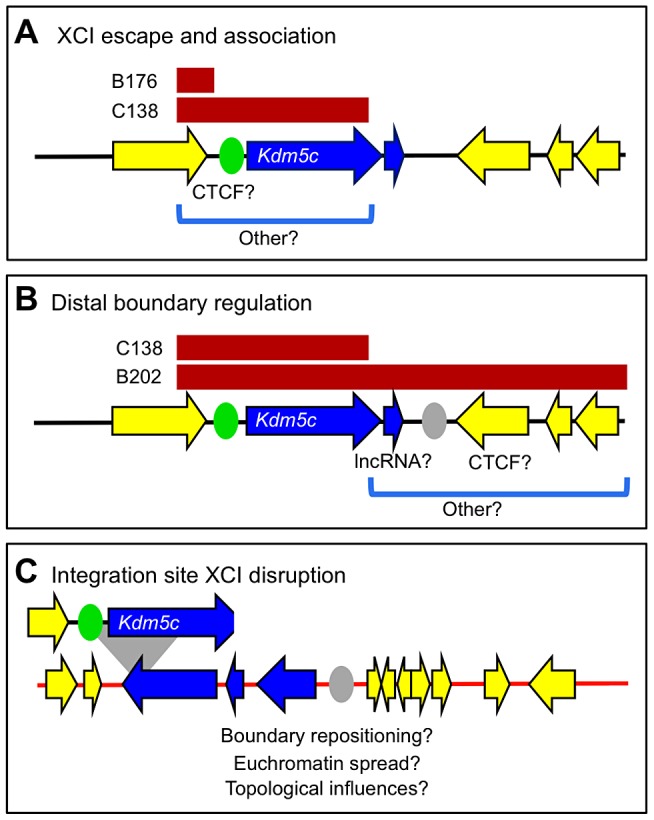
Two genetically separable regulatory activities at the Kdm5c locus.(A,B) Endogenous Kdm5c locus with transcripts ordered and XCI states annotated as in Figure 1 (not to scale). (A) An escape element that maps within the C138 BAC sequences (bracketed) is sufficient to direct Kdm5c-tg escape and long-distance escapee interactions. A previously described CTCF site is proposed to demarcate proximal boundary (green oval) [24]. (B) Regulation at the distal XCI boundary. While sequences sufficient to establish a distal XCI boundary (gray oval), are present in full length B202 BAC, they are absent in the short C138 transgene. (C) C138 transgene integration into the Tex11 locus (not to scale) results in aberrant inactive X expression of three distal genes (blue).